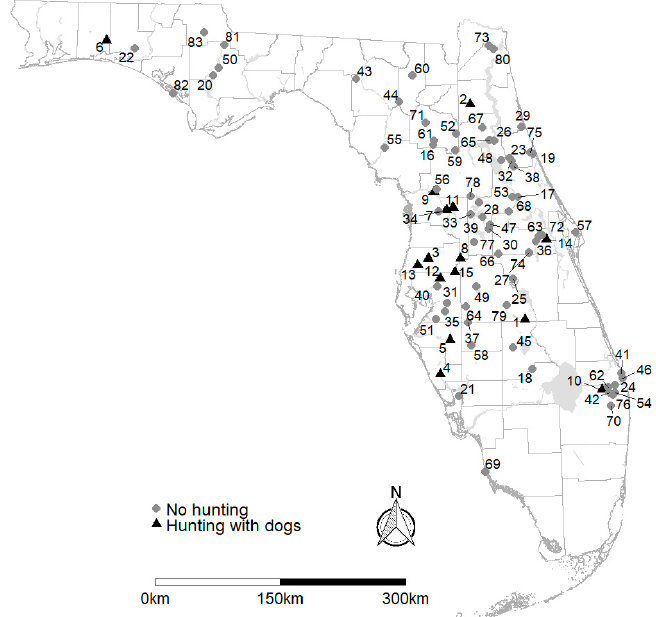
Figure 1. Sampling sites used to evaluate the exposure to pseudorabies (PrV) and Brucella spp. in wild pigs ( Sus scrofa ) in Florida, U.S. (2007–2014). Details (pathogen detection history, sample sizes, and